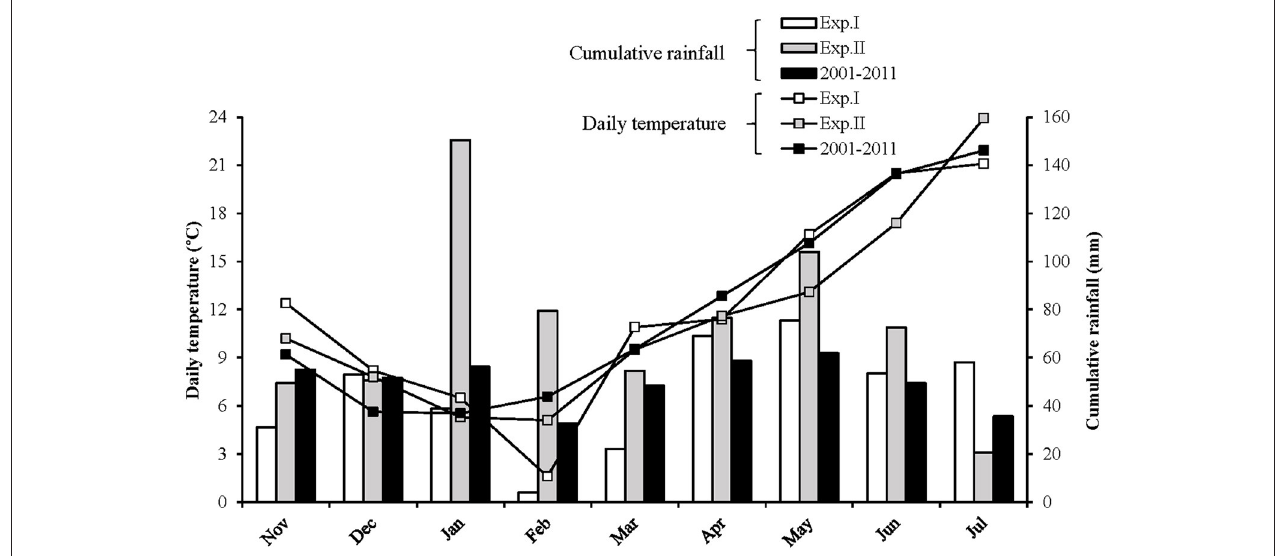
TABLE 1 | Characteristics of the cultivars used in this study. Species Cultivar Breeder Registration Height Precocity Durum Wheat L1823 INRA Unregistered + + + + Sculptur RAGT 2007 + + Faba Bean Castel SCA Epis-Sem 1987 Diver AgriObtentions 2008 Irena AgriObtentions 2002 Nordica NPZ/Serasem 2010 Winter Pea AOPH10 AgriObtentions Unregistered Geronimo